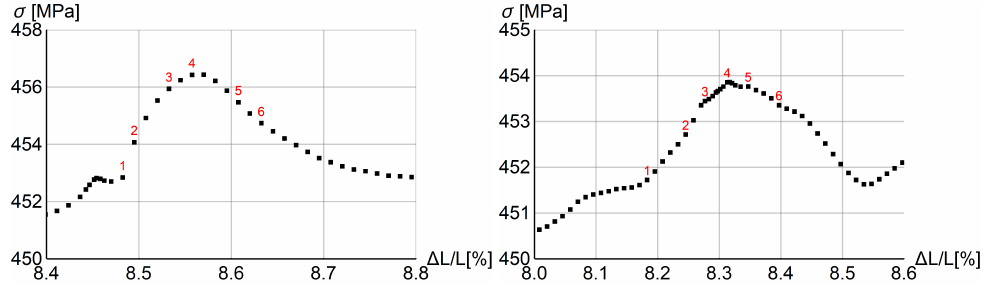
Figure 13. Stress vs. relative extension for selected serration and two values of internal length l = 0 ( left ) and l = 20 mm ( right